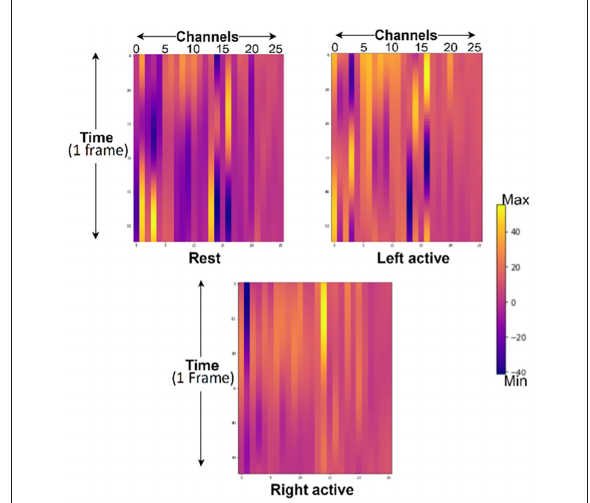
FIGURE10 Hemodynamic response from rest, left- and right-motor task blocks of subject 2 from Dataset A where channels 1–13 represents HbO and 14–26 represents HbR. Yellow lines represent maximum, and purple represents minimum values